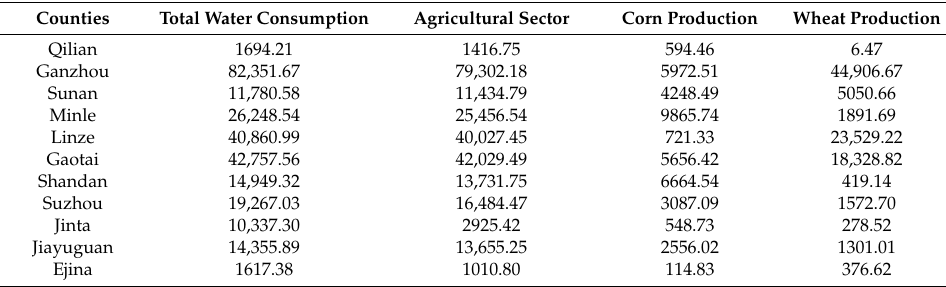
Table 1. Water consumption for key sectors at county level of the Heihe River Basin (10 4 m 3 ). Counties